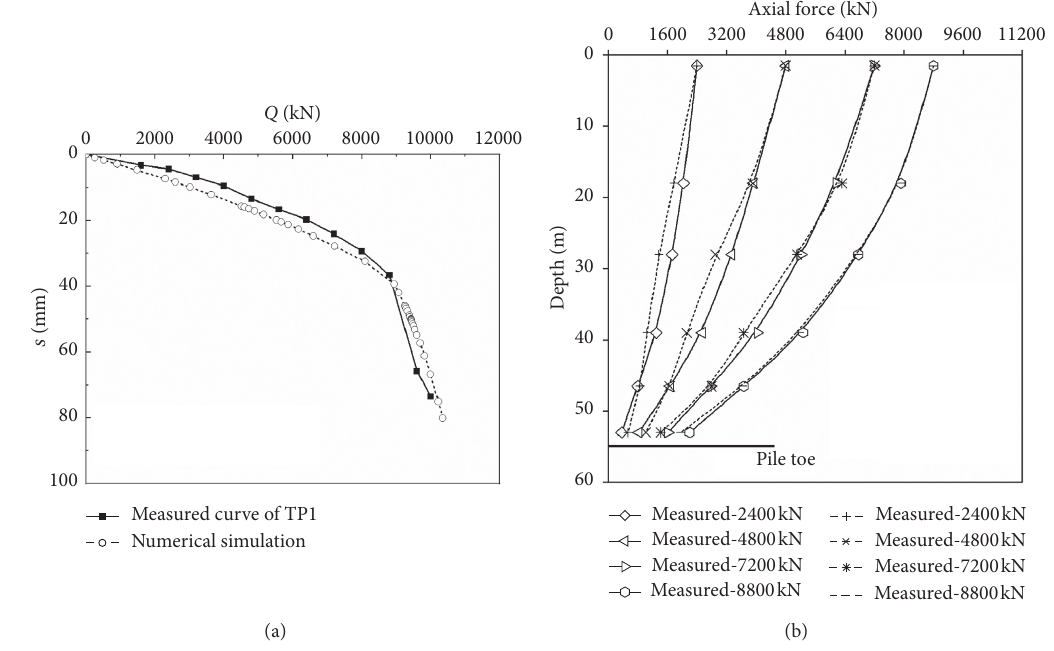
Figure 5: Comparison between FEA and measured values. (a) Q-s curve. (b) Axial force of the PPEB pile.